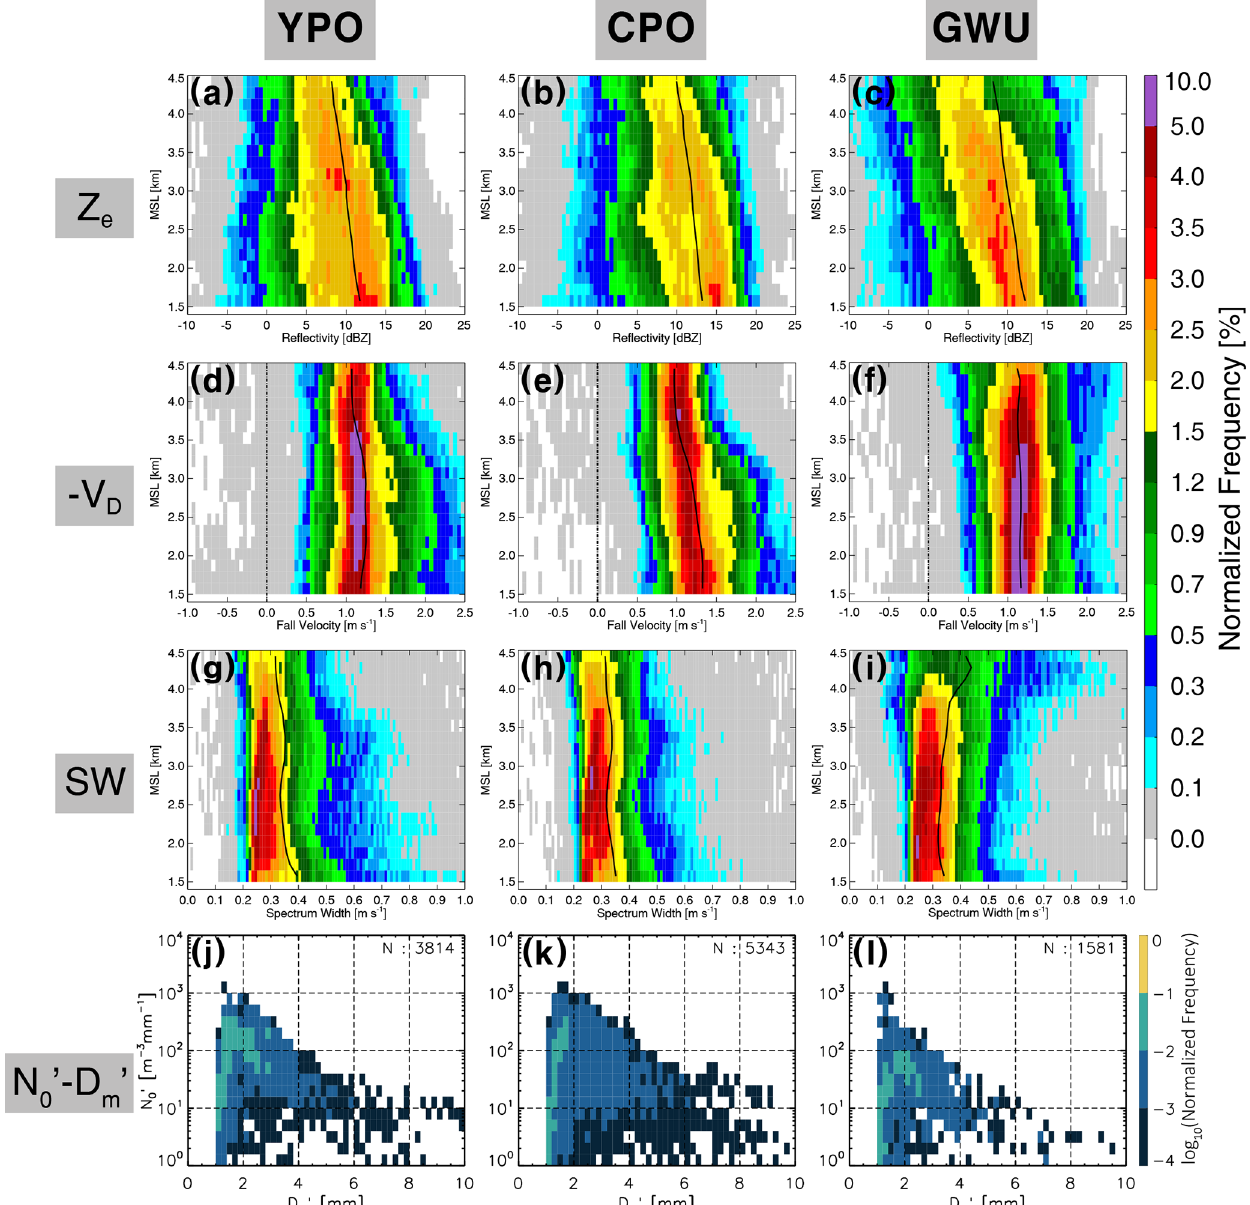
Figure 11. Same as in Fig. 7 except for the warm-low events. The mean liquid-equivalent precipitation rate from the Z e –SR relationship at 24.23GHz (Souverijns et al., 2017) at 1.5km height is 0.84, 1.15, and 0.93mmh − 1 for YPO, CPO, and GWU,